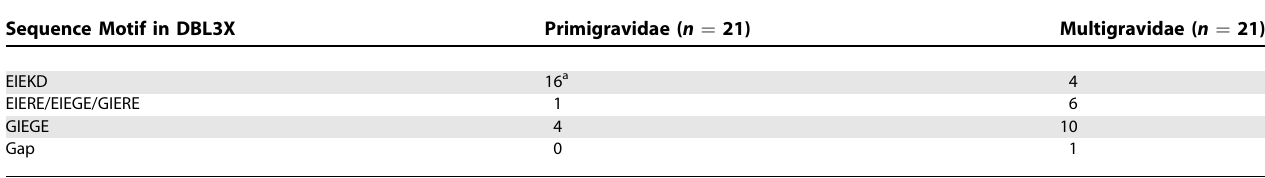
Table 1. Sequence Signature in DBL3X Position 158–162 of VAR2CSA Expressed by 42 Parasites Infecting either Primigravidae or